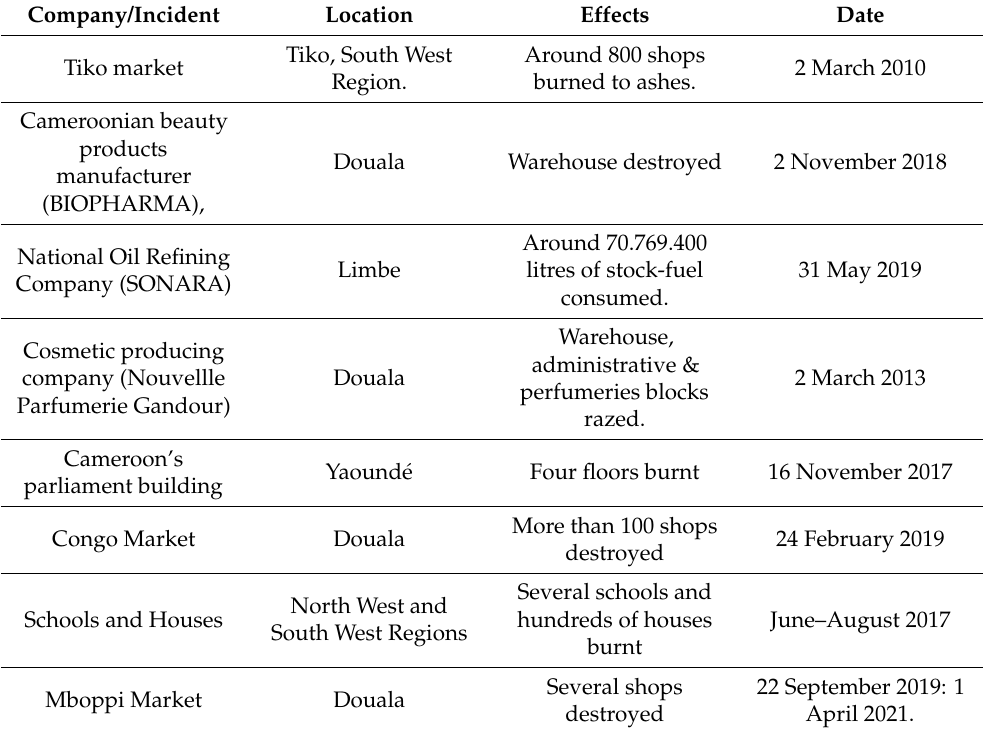
Table 5. Some prominent commercial fire incidents in Cameroon from 2010 to